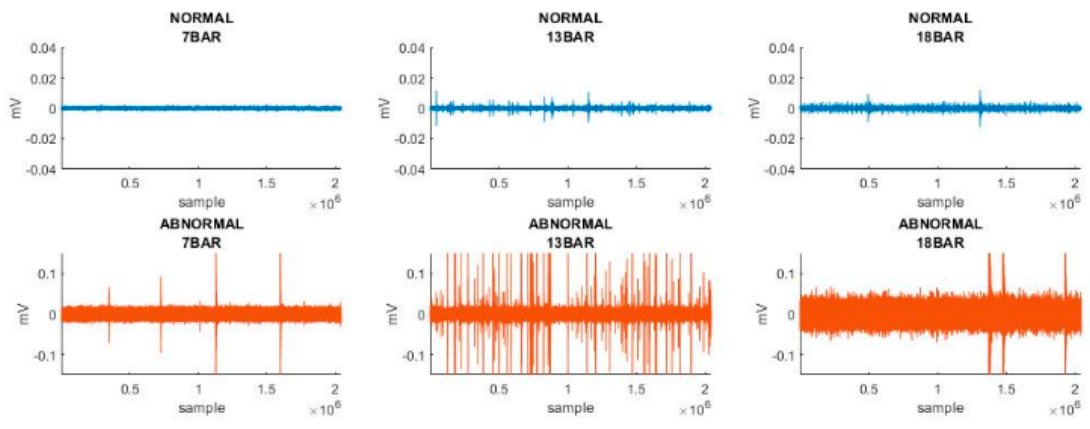
Figure 4. Acoustic emission (AE) signals from channel 2 for leak L3.